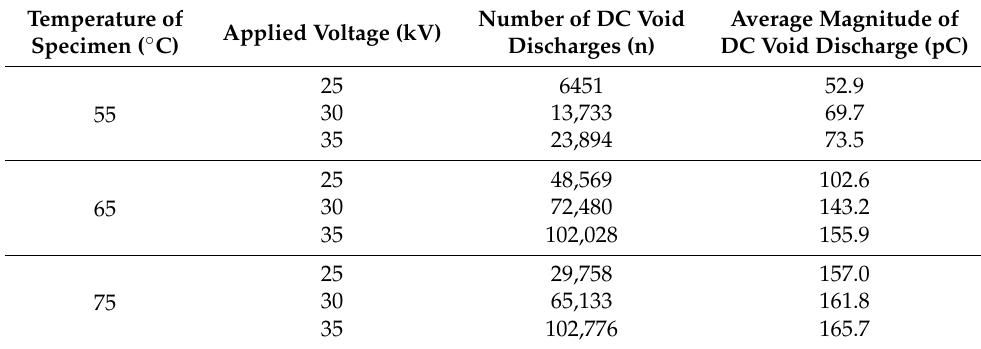
Table 2. Average magnitude of DC void discharge and number of DC void discharges according to the specimen temperature and the magnitude of the applied